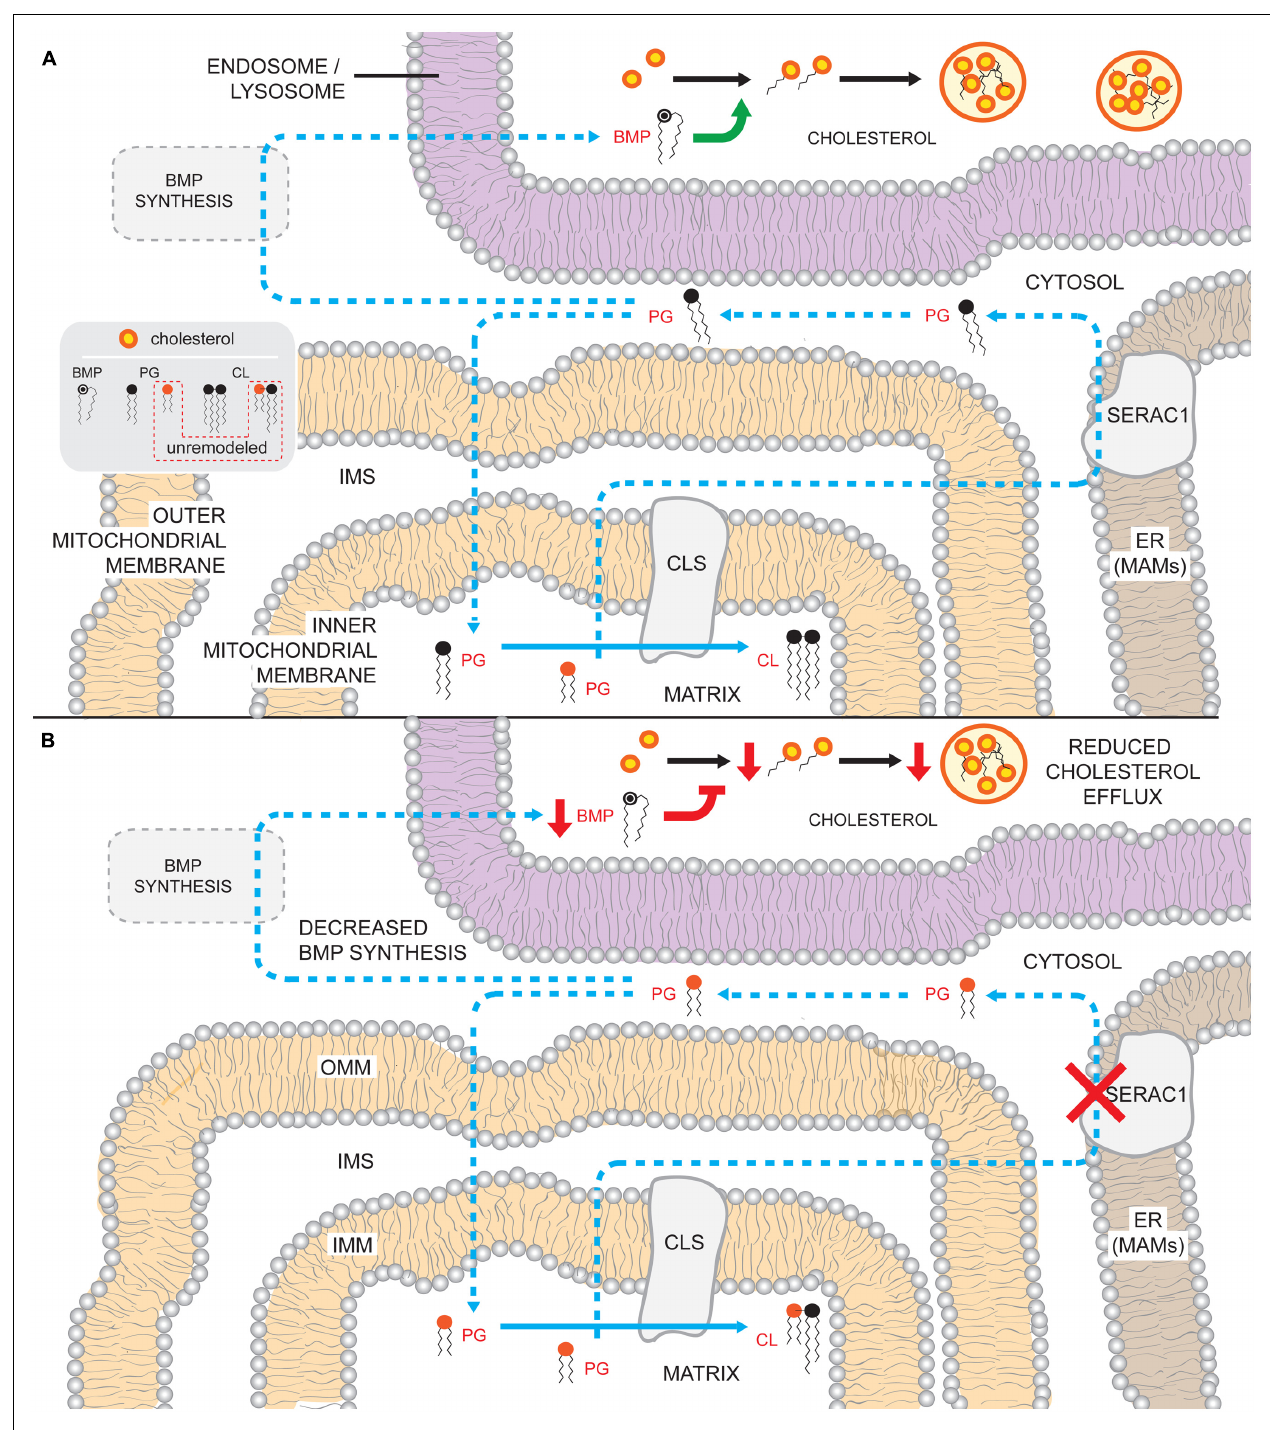
FIGURE 6 | Potential consequences of the absence of SERAC1 activity. (A) PG that is generated on the matrix-leaflet of the IMM is trafficked out of the mitochondrion and remodeled by SERAC1 on the ER MAMs. Remodeled PG can subsequently serve as substrate for BMP and CL synthesis. BMP in the endosomsal/lysosomal compartments regulates (green arrow) cholesterol esterification and trafficking out of the compartment. (B) In the absence of a functional SERAC1, PG is not remodeled and accumulates shorter acyl chain